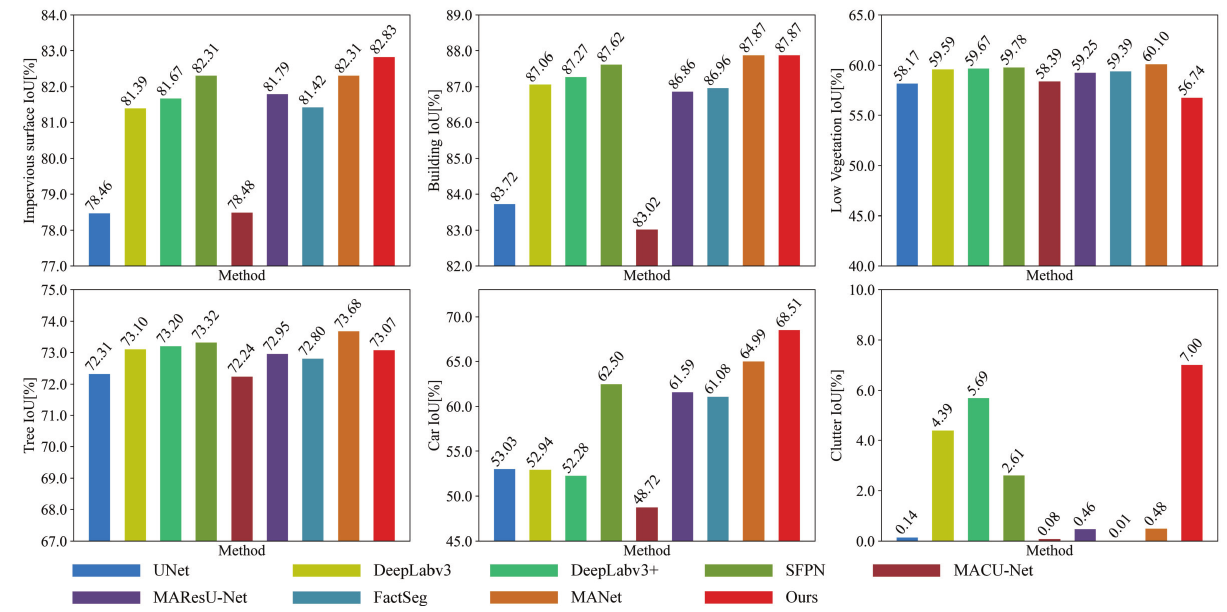
Figure 6. The comparison of the proposed PGNet and SOTA methods on the ISPRS Vaihingen